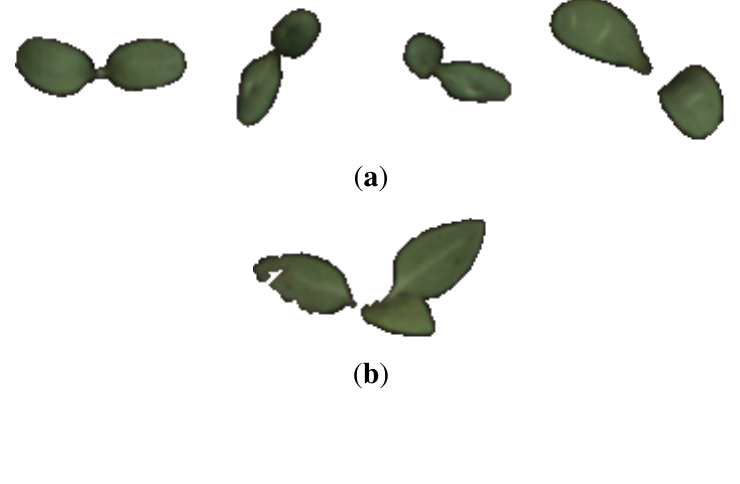
Figure 10. RBF-classification errors. ( a ) Cornflower sample classified as nightshade; ( b ) Nightshade classified as